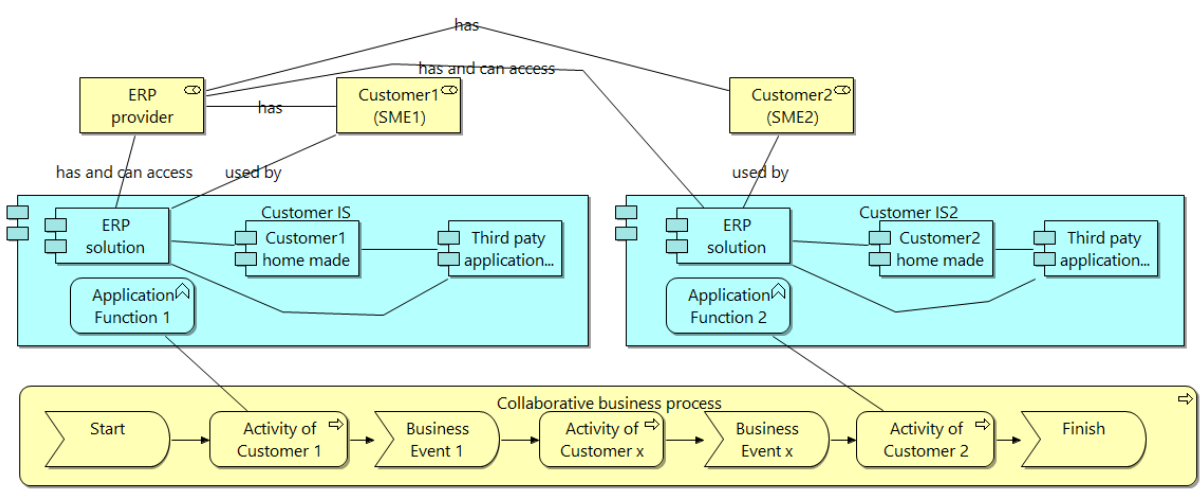
Figure 1. ERP vendor and its customers which are involved in cross-enterprise business